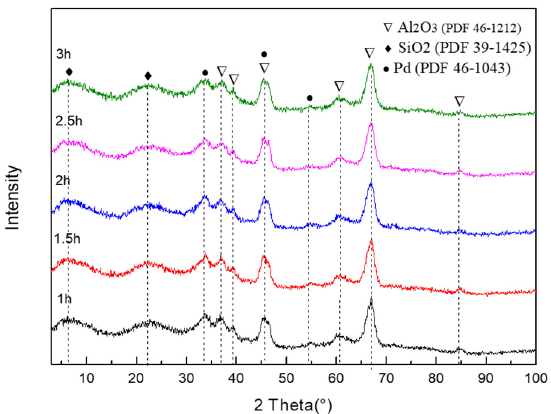
Figure 4. XRD pattern of the Pd–Ni/ γ Al 2 O 3 –SiO 2 bimetallic catalysts at different reduction times.